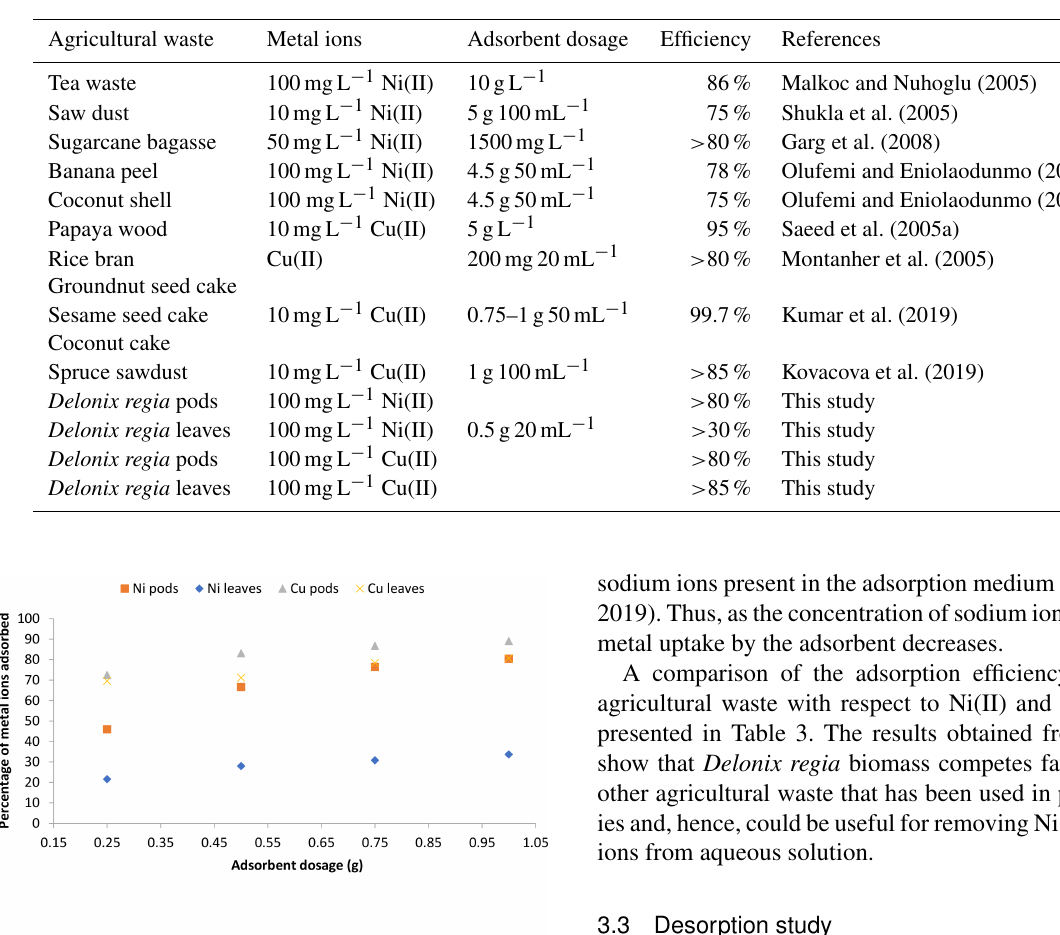
Table 3. Comparison of the amount of Ni(II) and Cu(II) ions removed with different agro-waste biomass and with Delonix regia pods and leaves.